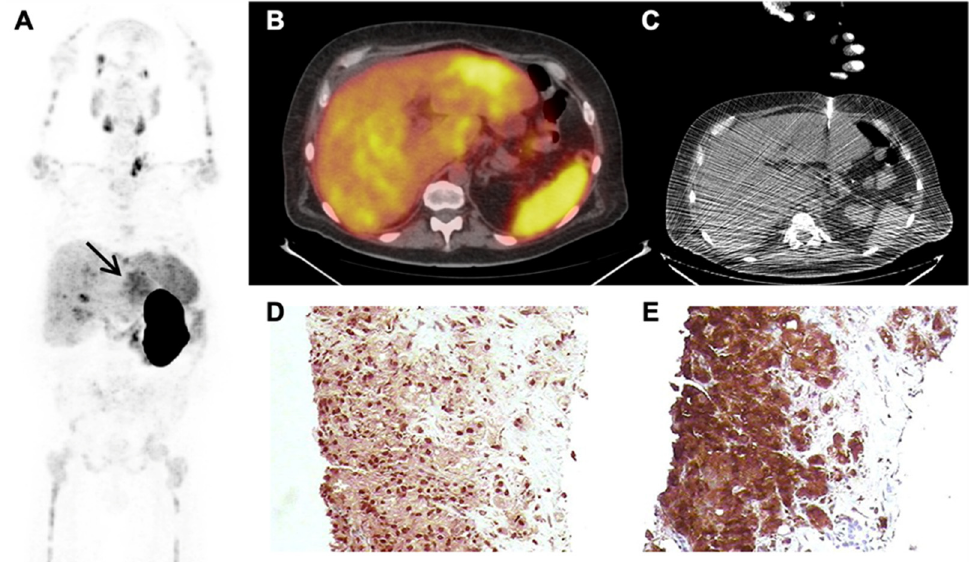
Figure 2. Case example of a PSMA-PET-guided liver biopsy. A 53-year-old man diagnosed with high-risk PCa treated with radical prostatectomy and pelvic lymph node dissection in 2015. After four years of biochemical relapse and progression under hormonal therapy with a diagnosis of CRPC. He underwent a PSMA-PET in March 2019 with a PSA of 75.0 ng/mL. PSMA uptake was demonstrated in pelvic and retroperitoneal lymph nodes, multiple bones, and within the liver ( A , B ). With known PET information, the patient underwent a liver biopsy two days later ( C ). Histopathol- ogy confirmed metastatic adenocarcinoma of the prostate positive for NK3.1 (( D ), 400×) and PSA (( E ), 400×).